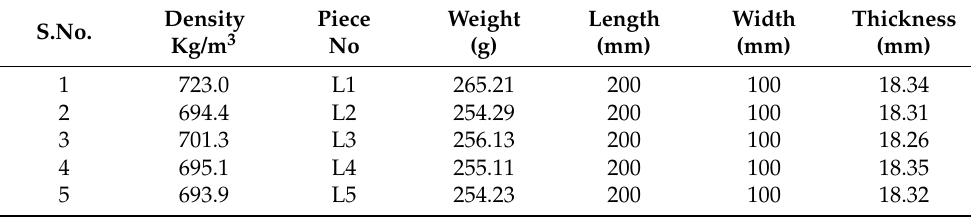
Table 16. Density profile across